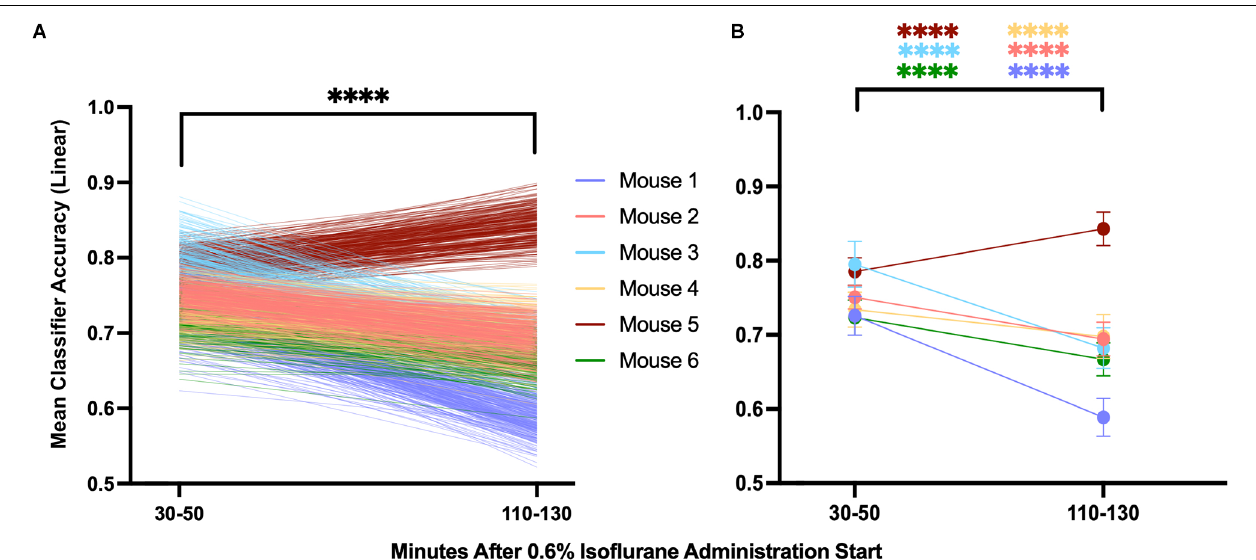
FIGURE 10 | Population and individual neural inertia decrease over time. Neural inertia as measured by mean classifier accuracy was compared over the first 20 and final 20 min of the 100 min beginning 30 min after the final 0.6% isoflurane step. Across animals (A) , neural inertia showed a significant decrease over the measured period (values from individuals shown by color). By individual (B) , five of six animals showed a significant decrease in neural inertia, while the outlier (mouse 5) had an increase in neural inertia over the same period (Wilcoxon matched-pairs signed rank test and two-way ANOVA with Šídák’s multiple comparisons test, respectively). **** p <